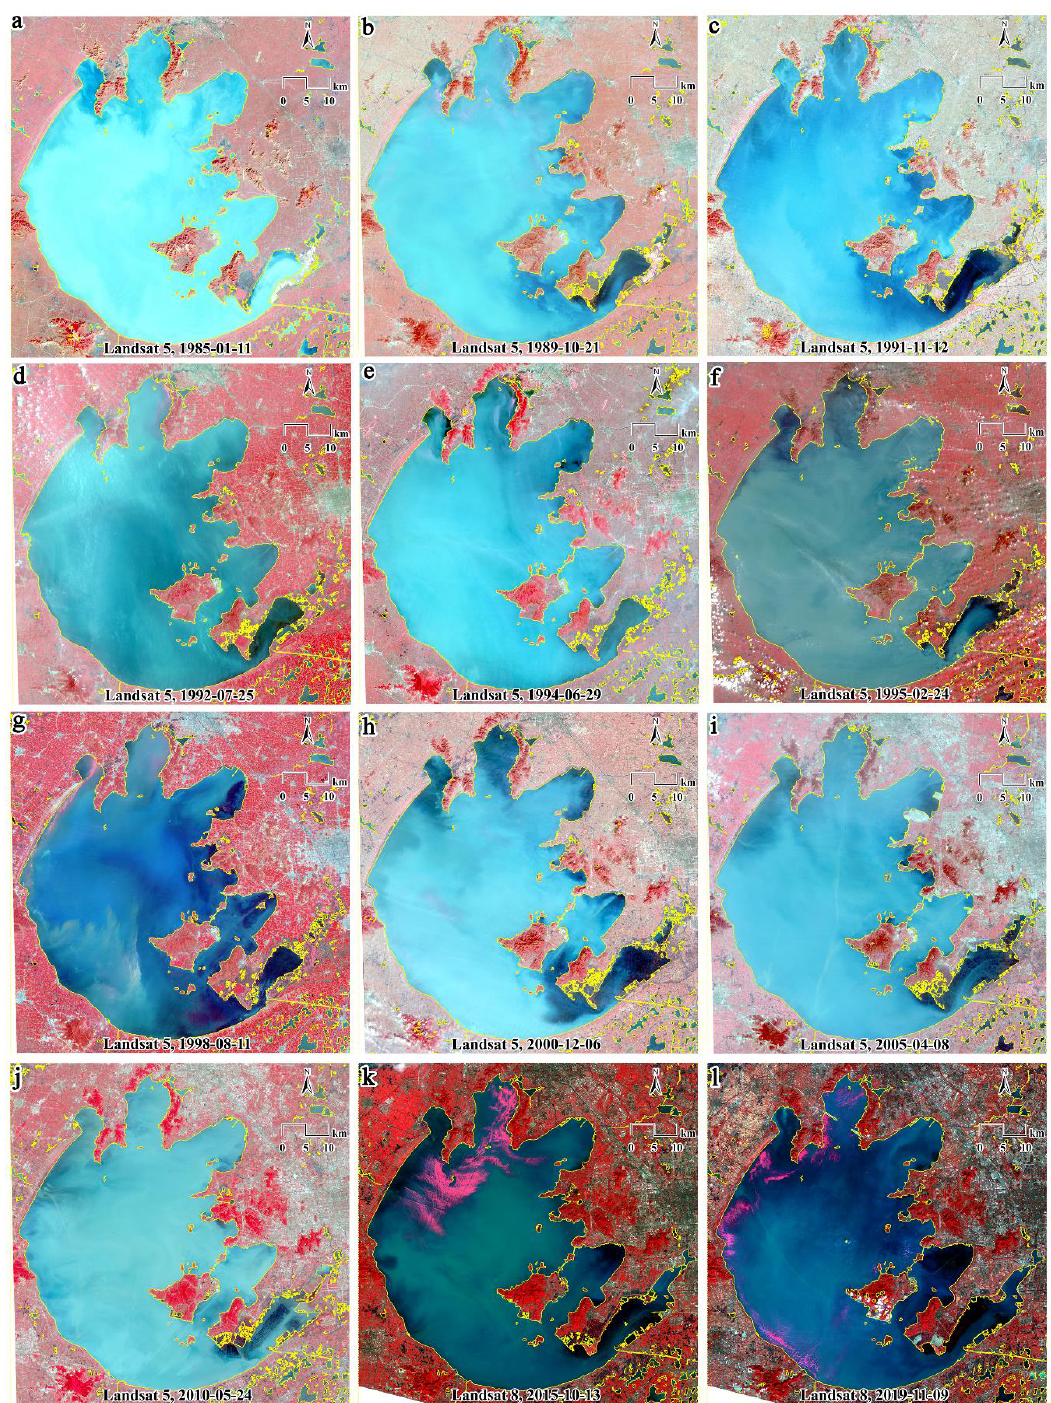
Figure 7. Water extraction for Taihu Lake during 1984 – 2019 using Landsat series images (the yellow line is the extracted water boundary, and the background image uses standard false color composition). Water extraction results from second shortwave-infrared band (SWIR2) of Landsat TM (Thematic Mapper) acquired in 1985-01-11 ( a ), 1989-10-21 ( b ), 1991-11-12 ( c ), 1992-07-25( d ), 1994-06-29 ( e ), 1995-02-24 ( f ), 1998-08-11 ( g ), 2000-12-06 ( h ), 2005-04-08 ( i ), 2010-05-24 ( j ), and of Landsat OLI (Operational Land Imager) acquired in 2015-10-13 ( k ) and 2019-11-09 ( l ).